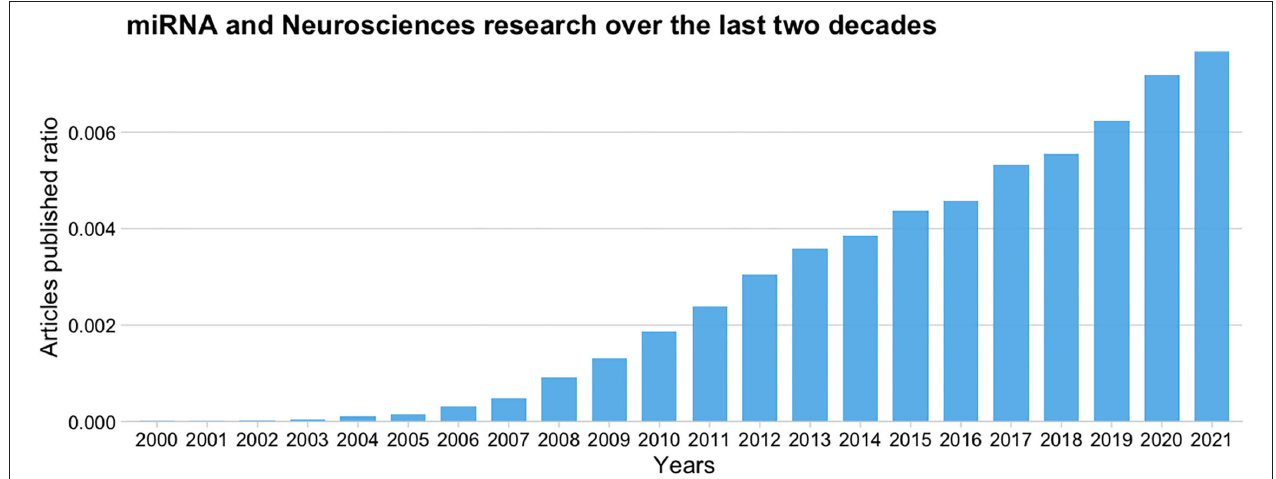
FIGURE 2 | Ratio of published articles on miRNAs and neurosciences to the total number of articles published over the last 20 years according to the Europe PMC database.